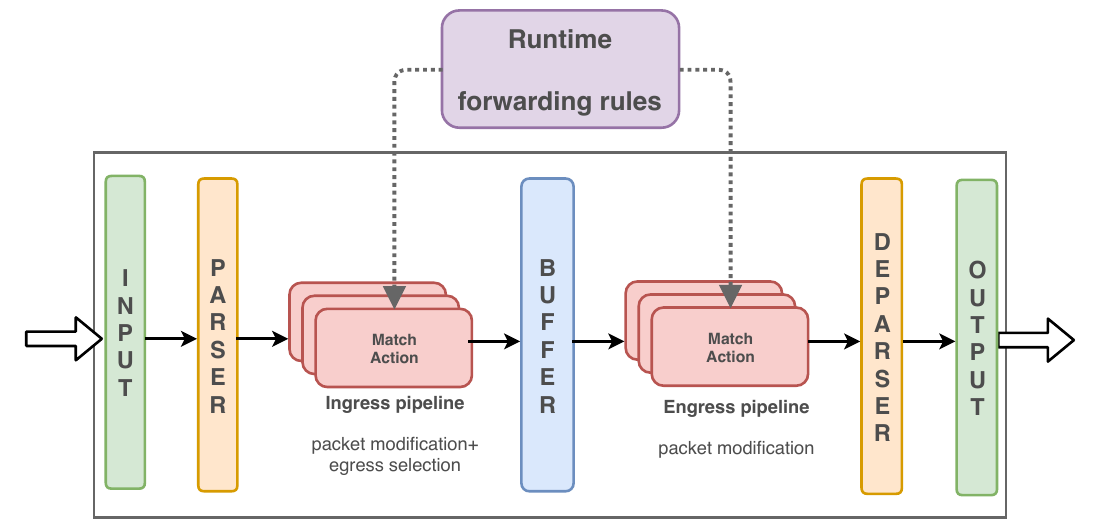
Figure 2. P4 processing